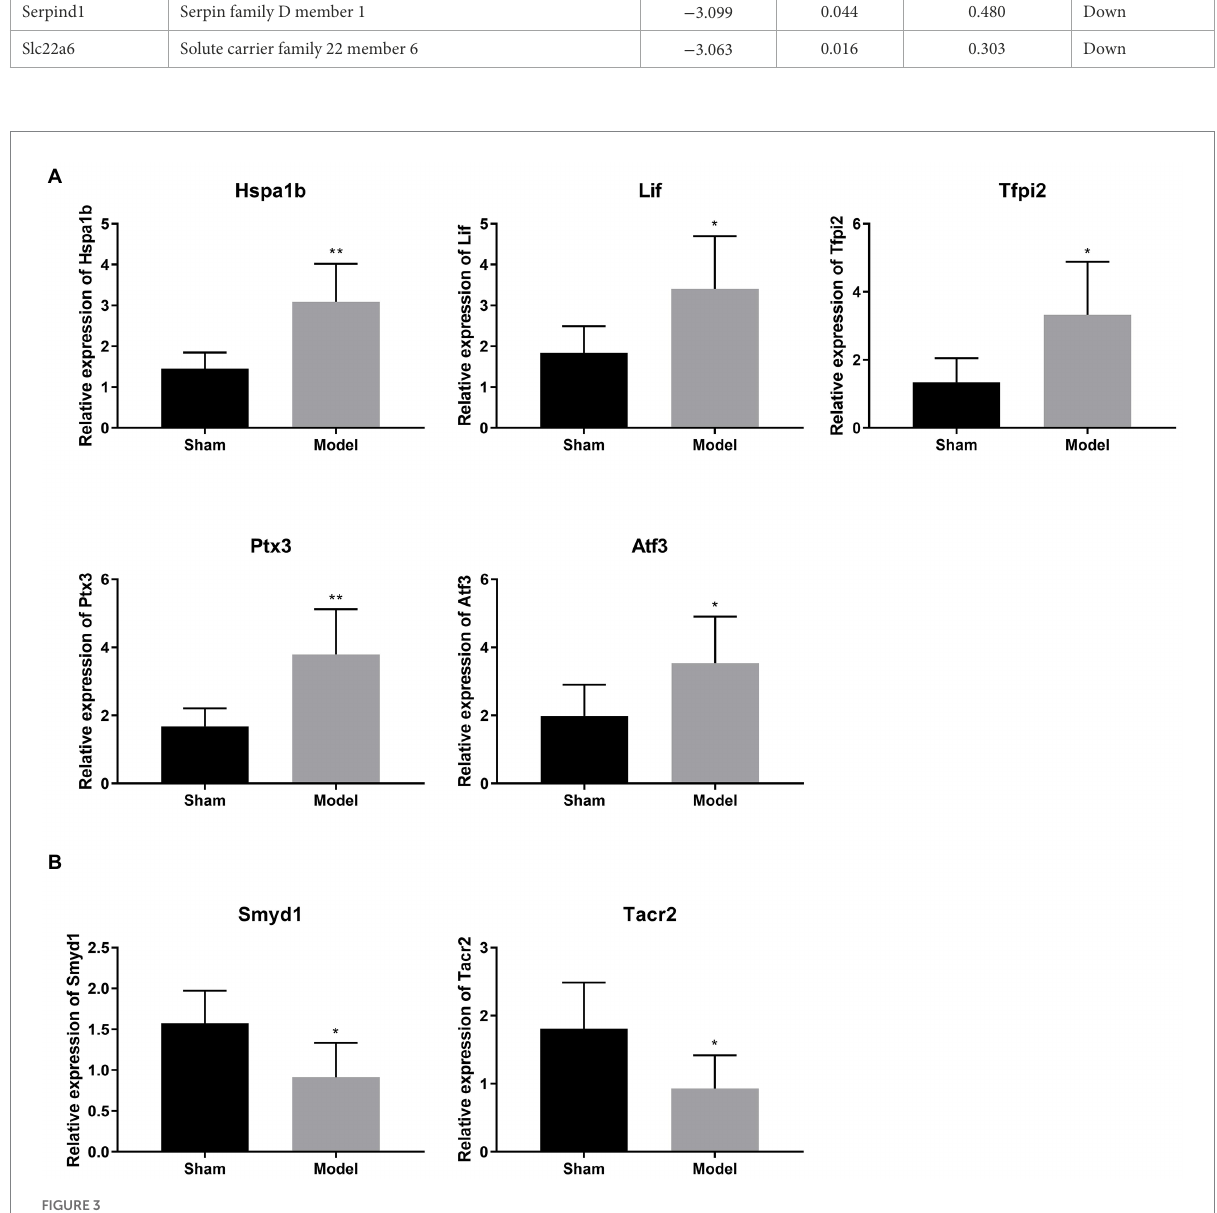
FIGURE 3 (A,B) Verification of 6 selected DEGs relating with ischemic injury by qRT-PCR ( N = 6 each group). * p < 0.05, ** p < 0.01 vs.